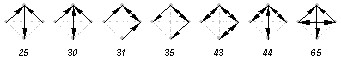
Examples of symmetric quadruplet patterns that are not over-represented.